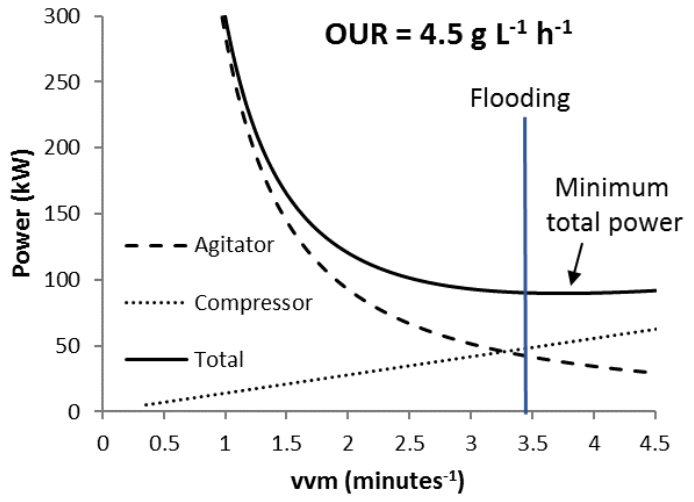
Figure 8. Scenario C3: Influence of vvm on compressor, agitator and total electrical power requirements for OUR = 4.5 g·L −1 ·h −1 ( C OL = 2 mg·L −1 ).